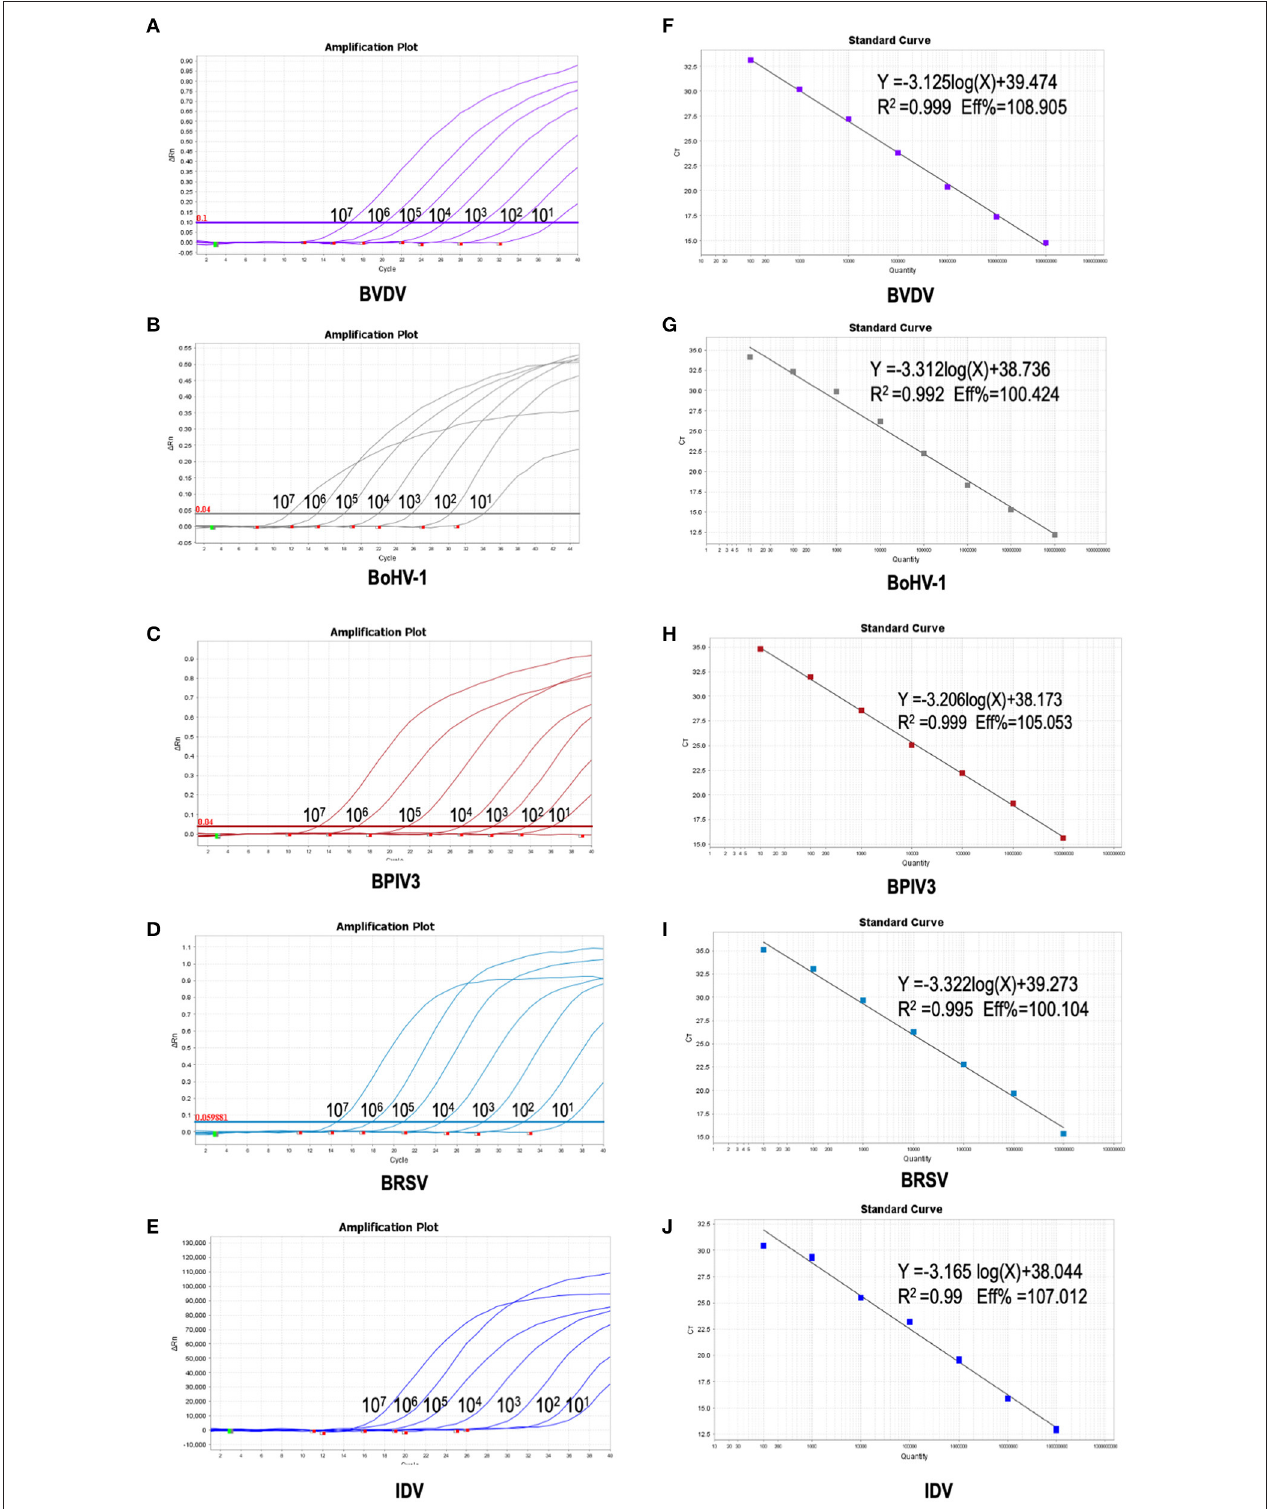
FIGURE 2 | Preparation of plasmid standards: (A–E) : amplification curves (X-axis: Cycle, Y-axis: 1 Rn) of BVDV, BPIV3, BRSV, BoHV-1 and IDV for each plasmid standard with concentrations ranging from 1 × 10 7 copies/ µ L to 1 × 10 1 copies/ µ L; (F–H) : standard curves of plasmid standards of BVDV, BPIV3, BRSV, BoHV-1and IDV. (F) : BVDV: Y = − 3.125log(X) + 39.474 R 2 = 0.999 Eff% = 108.905; (G) : BoHV-1: Y = − 3.312log(X) + 38.736 R 2 = 0.992 Eff% = 100.424; (H) : BPIV3: Y = − 3.206log(X) + 38.173 R 2 = 0.999 Eff% = 105.053; I: BRSV: Y = − 3.322log(X) + 39.273 R 2 = 0.995 Eff% = 100. 104; (J) : IDV: Y = − 3.165 log(X) + 38.044 R 2 = 0.99 Eff% =